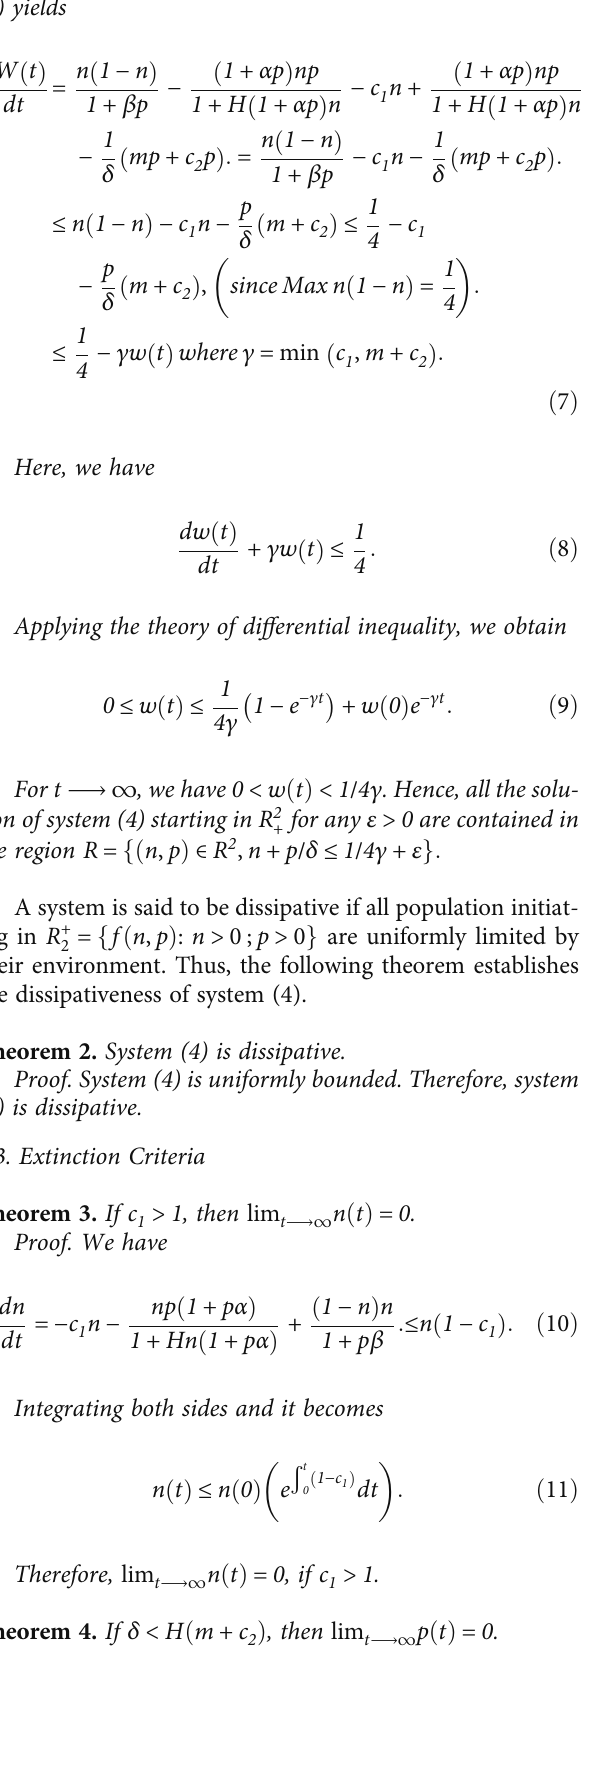
Table 1: Parameter de fi